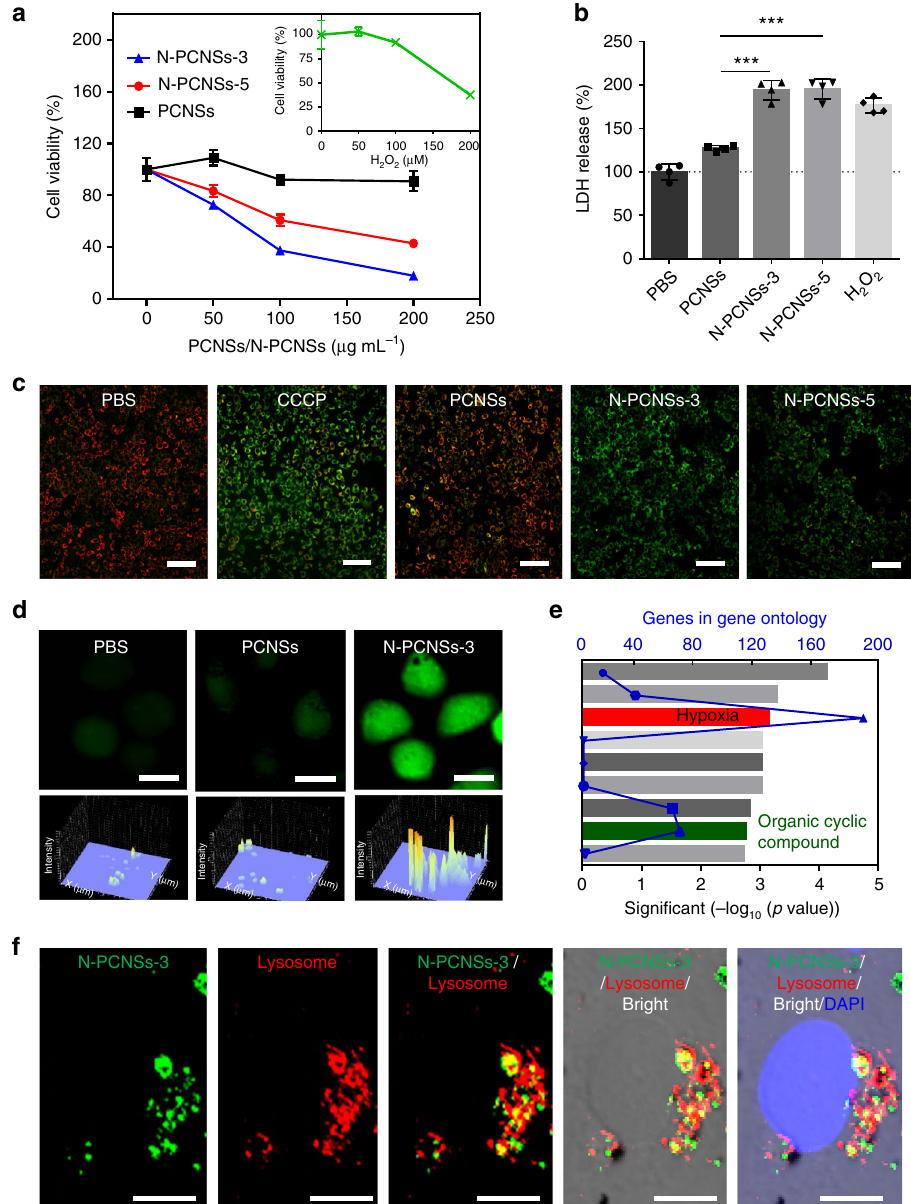
Fig. 3 Cellular localization of N-PCNSs in HepG2 and its effects on viability. a Effect of N-PCNSs on HepG2 cell viability ( n = 6). Insert: H 2 O 2 cytotoxic effects on HepG2. b Determination of cell membrane integrity by LDH assay. Statistical signi fi cance is assessed by unpaired Student ’ s two-sided t -test compared to the control group. *** p < 0.001. Mean values and error bars are de fi ned as mean and s.d. ( n = 4). c In fl uence of N-PCNSs treatment on mitochondrial membrane potential. Scale bar: 100 µ m. d ROS level in HegG2 cells after N-PCNSs-3 stimulation. Scale bar: 20 µ m. e Gene ontology analysis of biological process after N-PCNSs treatment. The changes of mRNA in responses to the hypoxia and organic cyclic compound were marked in the fi gure as Hypoxia and Organic cyclic compound, respectively. p values are assessed by Fisher ’ s exact test. f Localization of N-PCNSs in HepG2 cells. Scale bar: 10 µ m. The Pearson ’ s coef fi cient of N-PCNSs and lysosome is